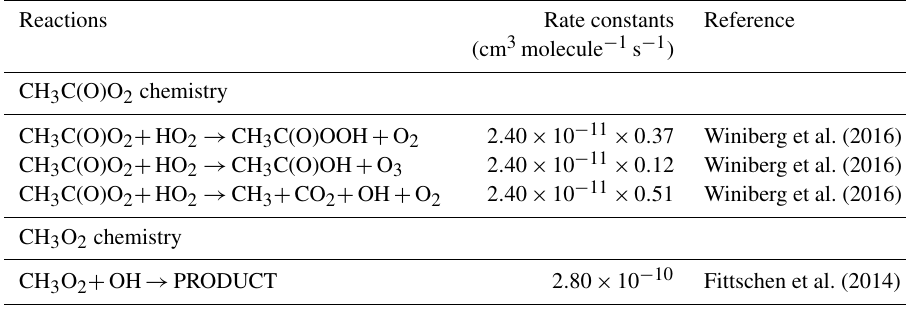
Table 2. Chemical mechanisms for CH 3 C(O)O 2 and CH 3 O 2 related chemistry modified or added to